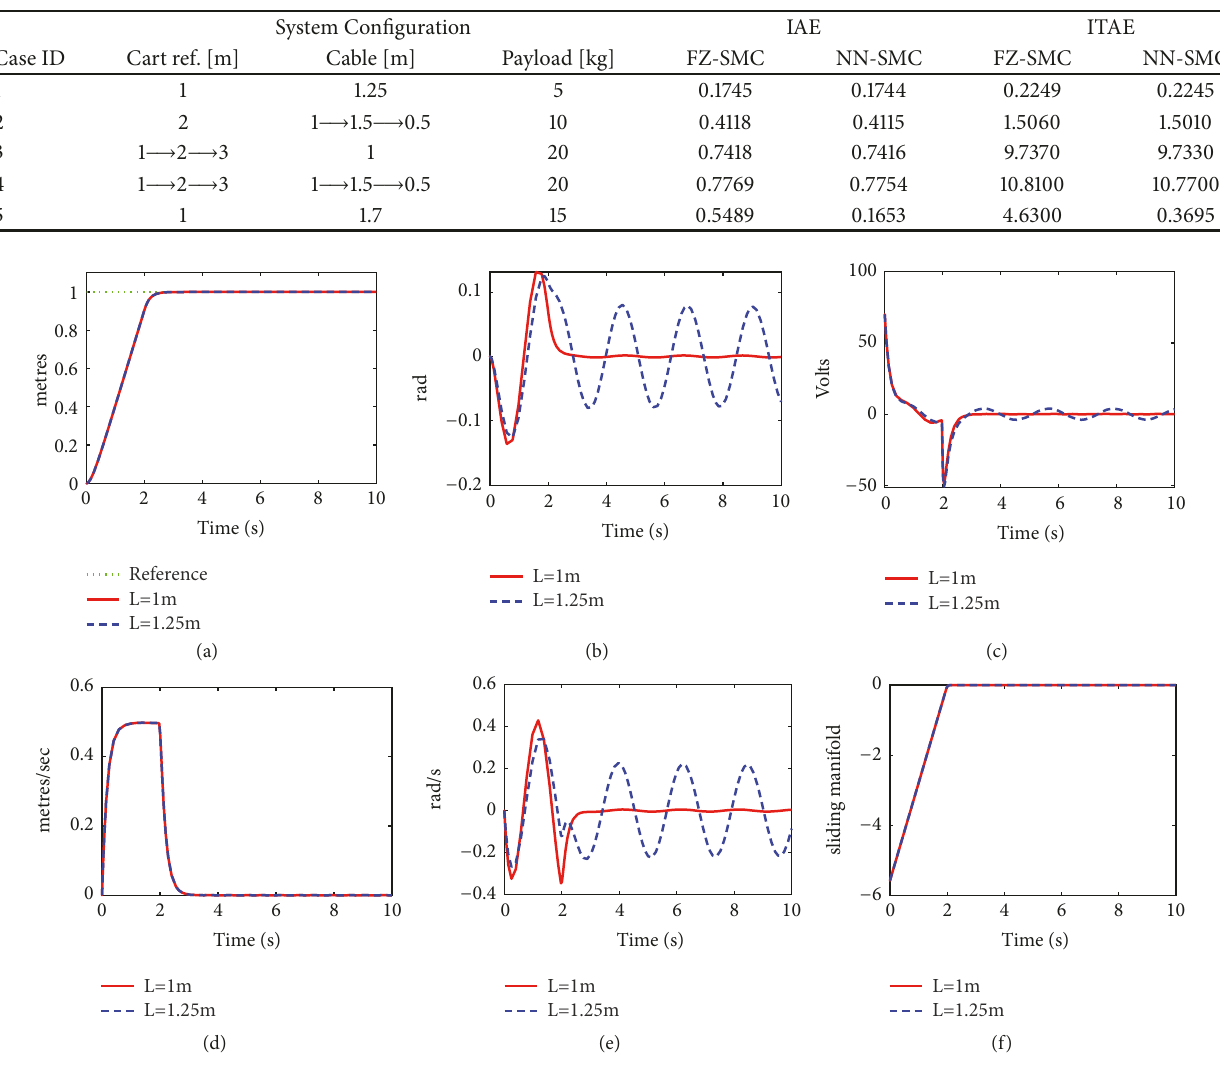
Figure 6: Responses without intelligent tuning algorithms. (a) Cart position. (b) Payload sway. (c) Control effort. (d) Cart velocity. (e) Sway angular velocity. (f) Sliding